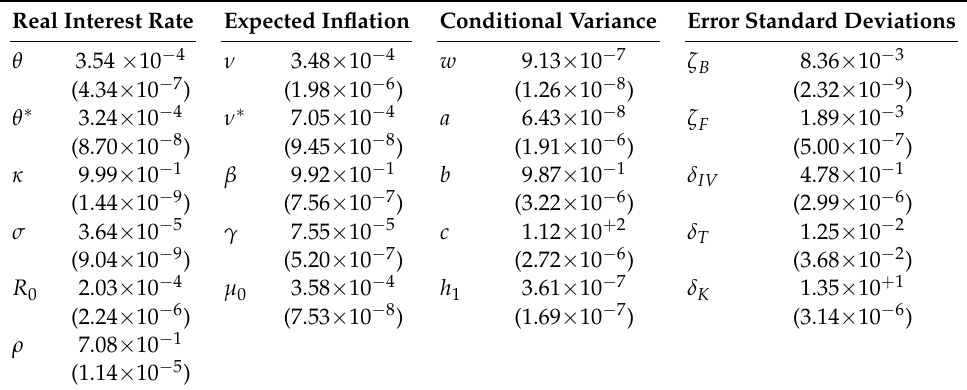
Table 4. Parameter estimates and standard errors for the full model when using CPI-U levels, nominal risk-free bond prices, inflation swap prices, and option implied volatilities. Real Interest Rate Expected